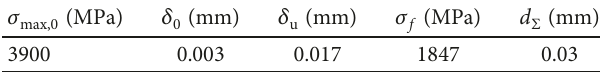
Table 1: Model parameters of IN718 used in